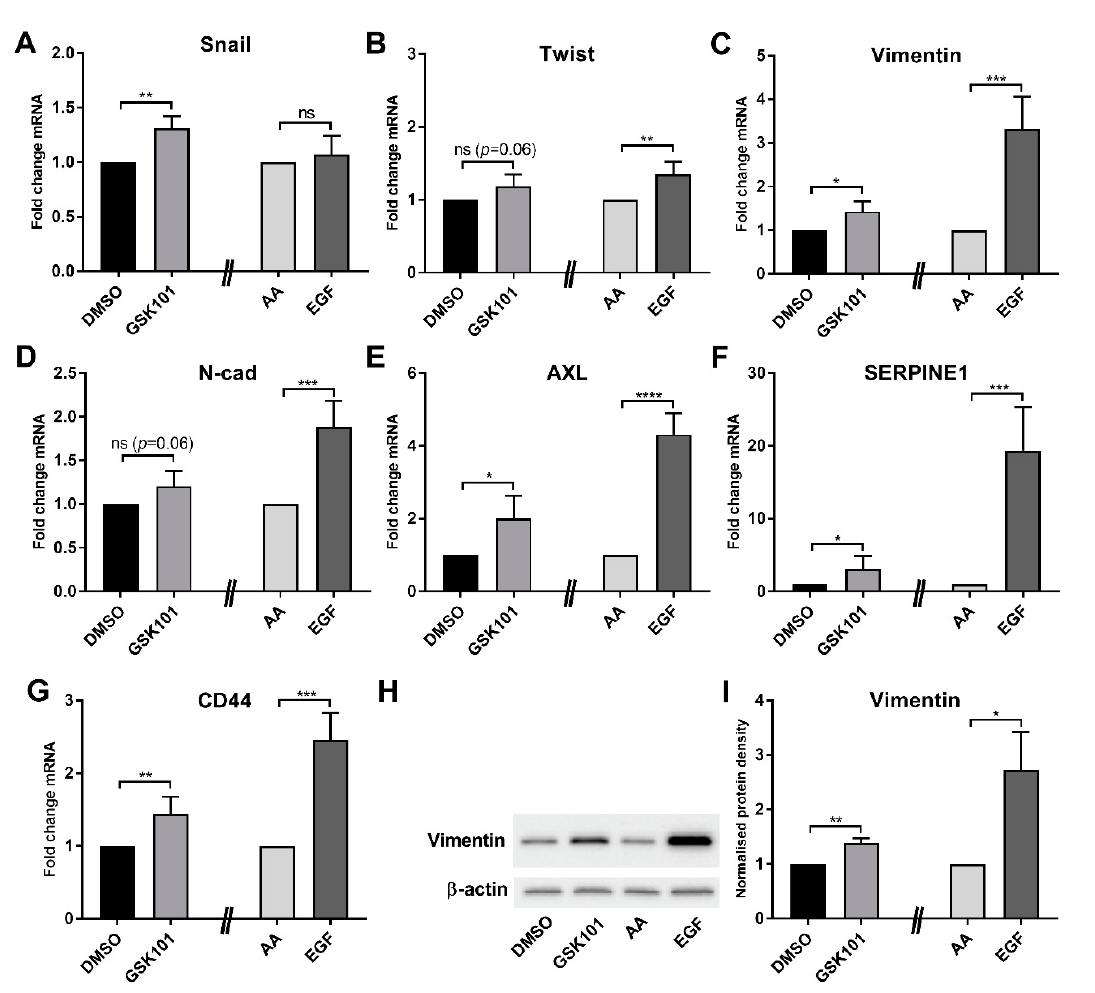
Figure 4. TRPV4 activation promotes EMT in PMC42LA cells. ( A – G ) The effect of TRPV4 pharmacological activator, GSK1016790A (GSK101), and EGF (10 ng/mL) on the mRNA expression of EMT markers in PMC42LA cells. Representative western blot ( H ) and densitometric analysis of three independent experiments ( I ) of the effect of GSK101 and EGF in TRPV4-silenced and control cells on vimentin protein expression in PMC42LA cells. ns = not significant, * p < 0.05, ** p < 0.01, *** p < 0.001, **** p < 0.0001, unpaired t -test, GSK101 compared to the dimethyl sulfoxide (DMSO) control, and EGF compared to its acetic acid (AA) control, n = 3, mean ± SD.